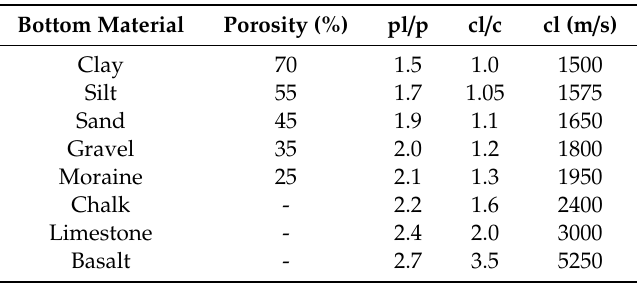
Table 1. Typical seabed materials and their